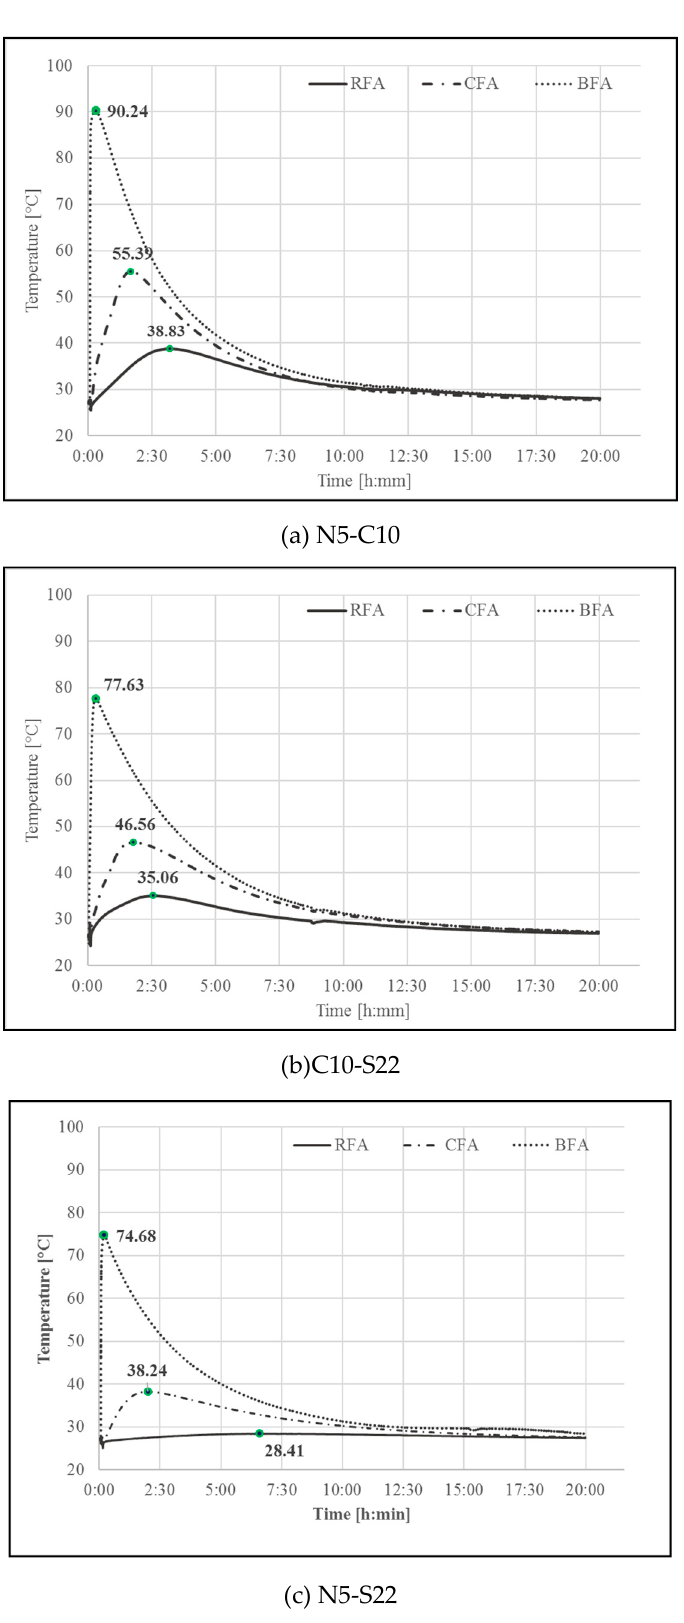
Figure 10. Temperature profiles of pastes with different activators ( a ) N5-C10, ( b ) C10-S22, and ( c ) N5-S22.